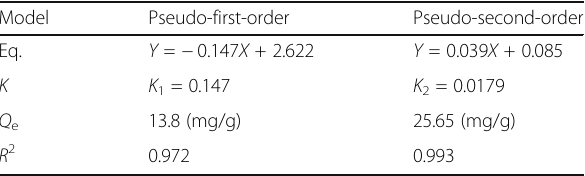
Table 3 The kinetic curves and the calculated parameters of the adsorption kinetic models